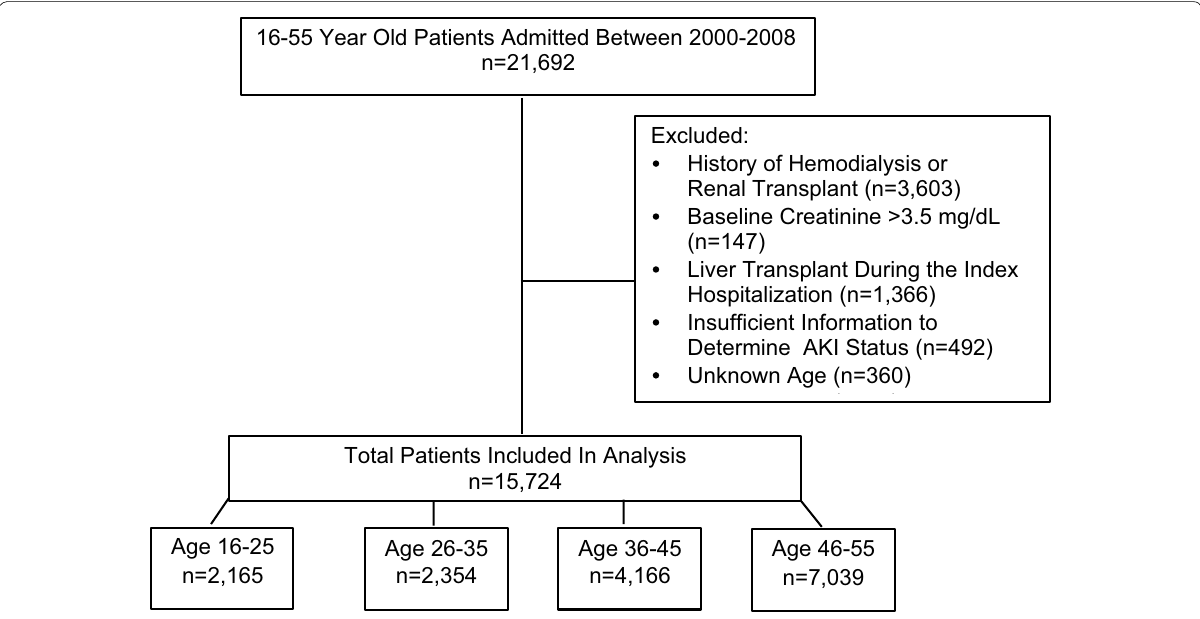
Fig. 1 Flow diagram of the study